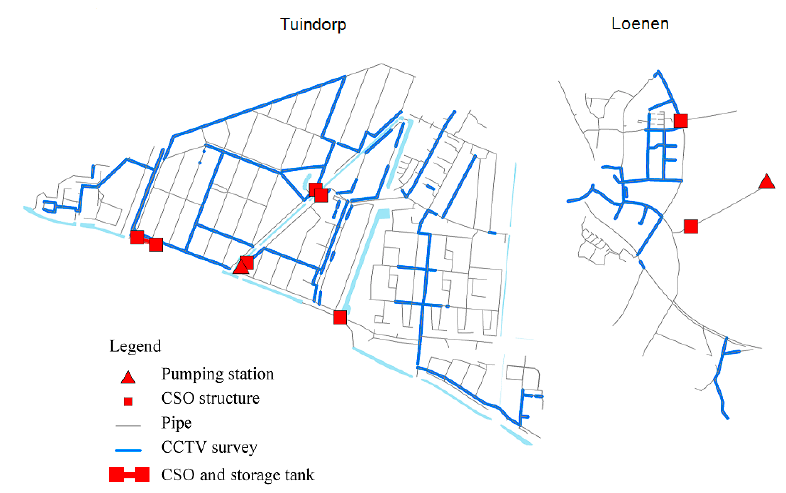
Figure 2. Layout of the ‘Tuindorp’ and ‘Loenen’ catchments.